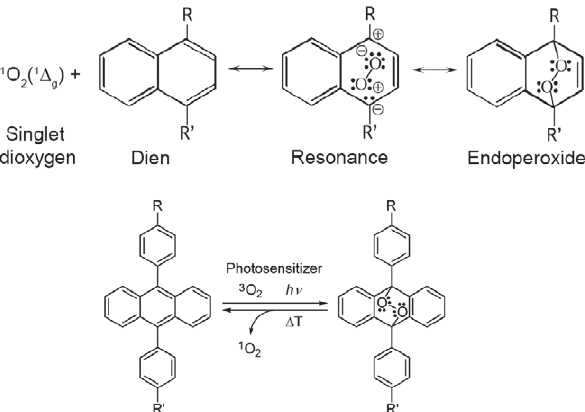
Figure 1. Affinity of singlet dioxygen for conjugated double bonds leading to the formation of an endoperoxide bridge. Endoperox- ides may also be formed from triplet dioxygen in the presence of a photosensitizer. One may speak of endoperoxides as “canned singlet dioxygen” owing to their ability to release 1 O 2 upon